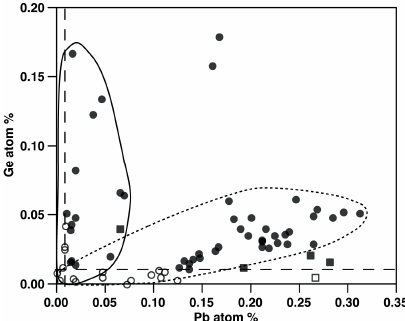
Figure 7. Pb vs. Ge (atom %) in willemite. Circles: TM06-15; squares: TM06-18. Dotted line outlines low Ge-high Pb trend, while solid line outlines the high Ge-low Pb trend. Open symbols are below detection limits, which are indicated by dashed lines.